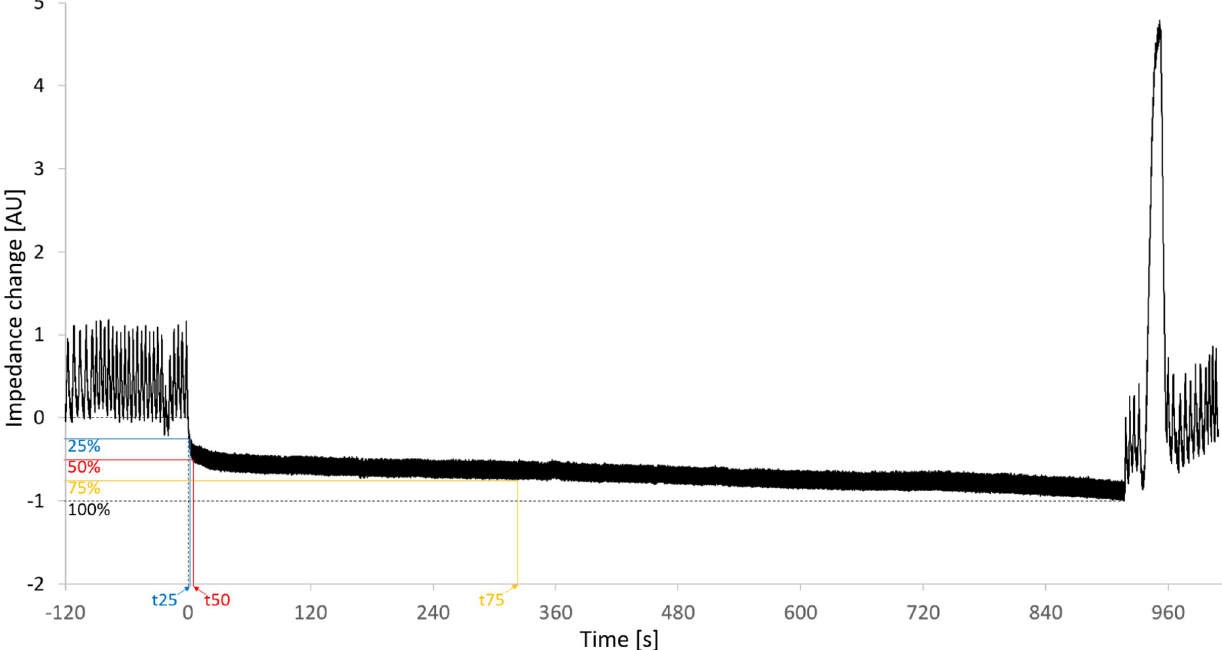
Fig 1. Example of a typical impedance signal time course. t25, t50 and t75 define the time to 25%, 50% and 75% respectively of total impedance reduction from